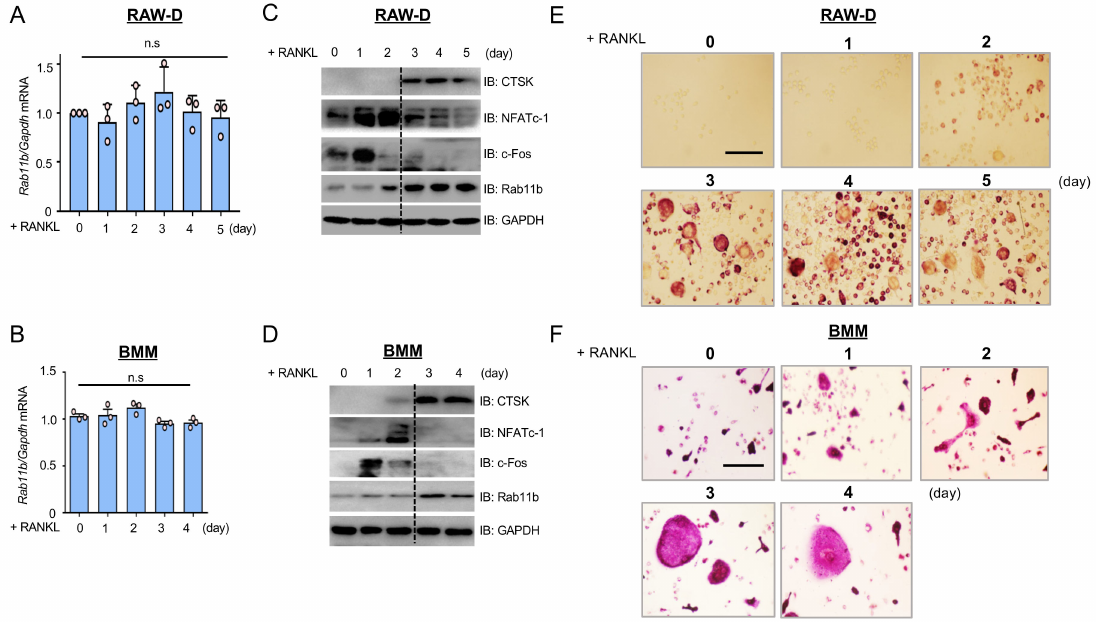
Figure 1. Rab11b upregulation at the late stage of osteoclastogenesis and the e ff ect of RANKL (300 ng / mL) on osteoclast and monocyte / macrophage colony stimulating factor (M-CSF) (30 ng / mL)